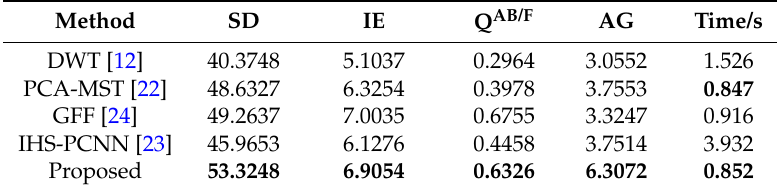
Table 3. Evaluation of aviation IR-visible image fusion performance.